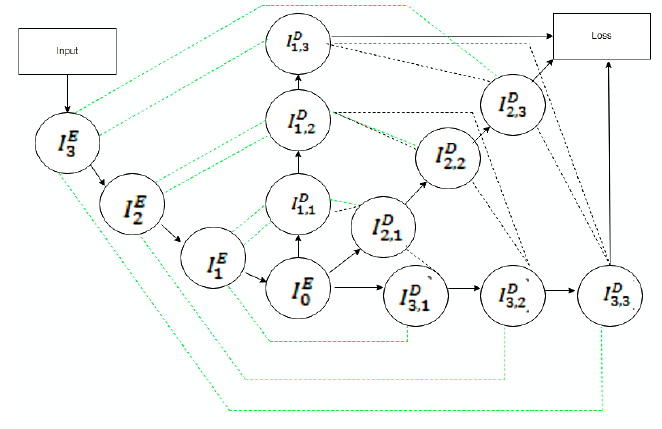
Figure 19. RDS UNET.